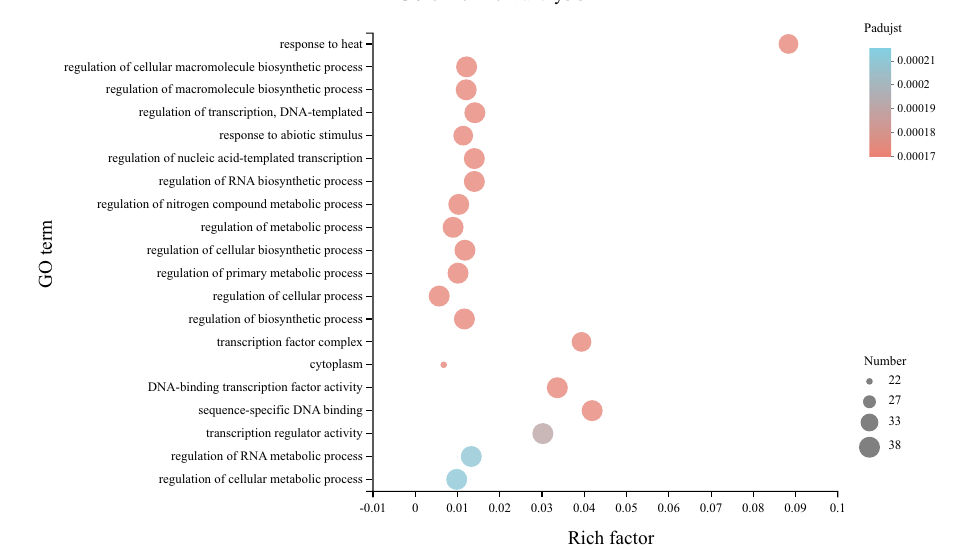
Figure 11. GO enrichment analysis of the PeHsf proteins relative to the GO database. The horizontal axis indicates the enrichment factor, and the size of the circle indicates the number of genes annotated with a given GO term. GOATOOLS (http:// github. com/ tangh aibao/ GOato ols) was used to assign GO annotations to HSFs, and Fisher’s exact test was used to identify biological functions enriched in the PeHsfs relative to the full GO database. Visualization were performed using the Majorbio online platform (https:// cloud. major bio. com).